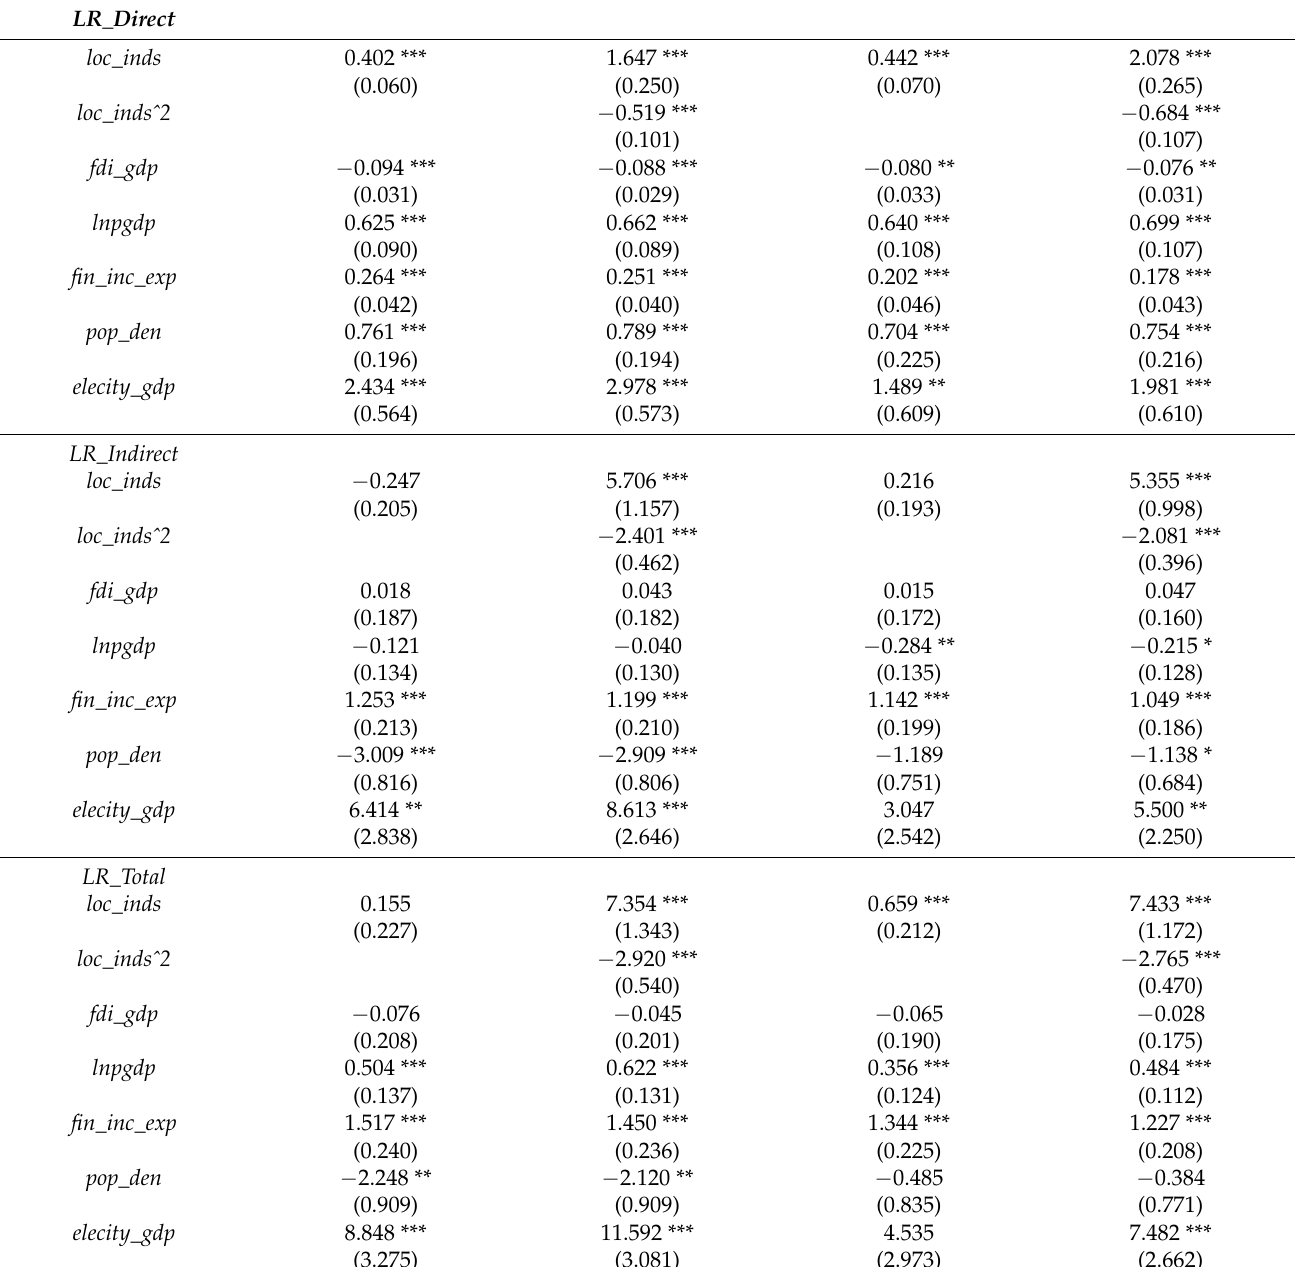
Table 5. Effect Decomposition of the Spatial Durbin